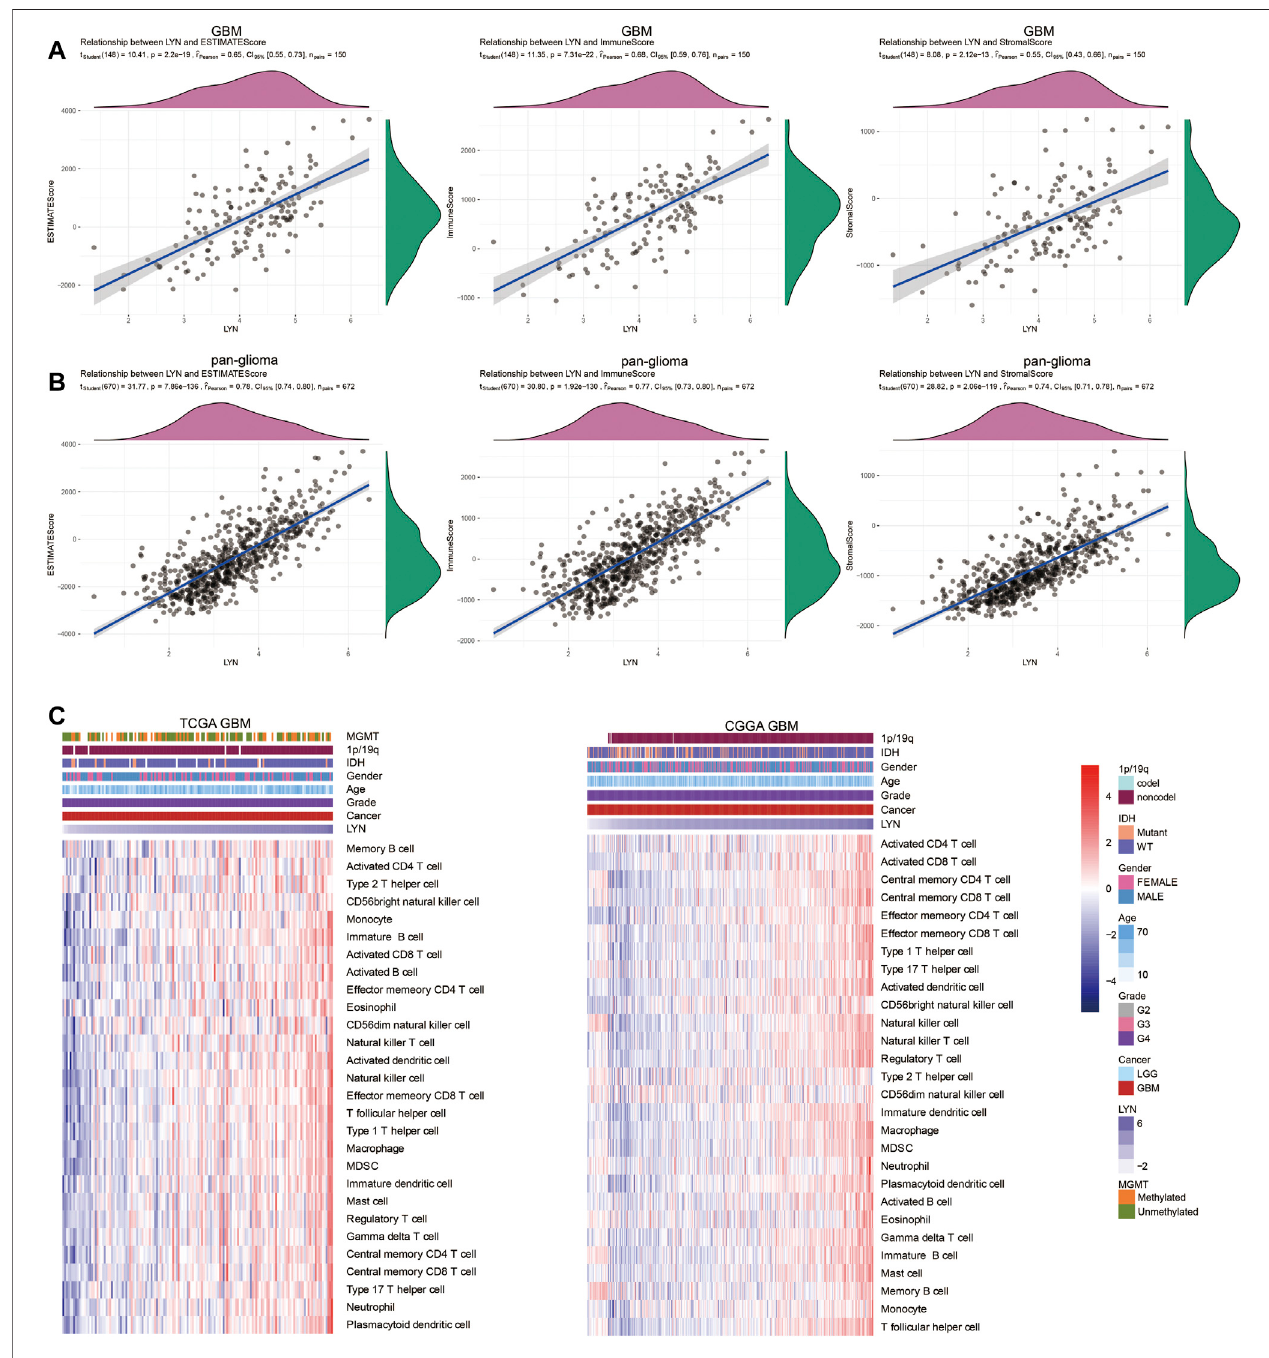
FIGURE 5 | LYN correlates with immune in fi ltration (A) . The correlation between LYN and Estimate Score, Immune Score, and Stromal Score in GBM samples in TCGA (B) . The correlation between LYN and Estimate Score, Immune Score, and Stromal Score in pan-glioma samples in CGGA (C) . Heatmaps illustrating the relationship between LYN and 28 immune cell types in TCGA GBM samples and CGGA GBM samples, respectively. The expression values are z-transformed. High expression values are colored red and low expression values are colored blue.